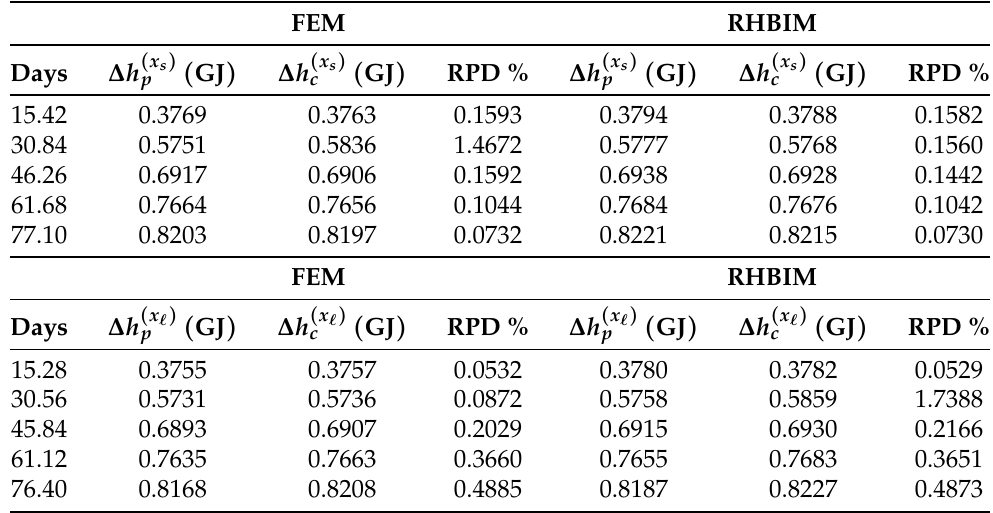
Table 3. Melting of KNO 3 according to the numerical and semi-analytical solutions to the absorbed energy ∆ h = h ( t ) − h ( 0 ) estimated through the new and old models. The RPDs are obtained from the example shown in Figure